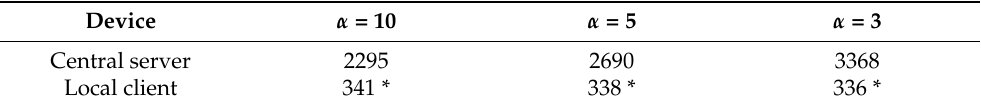
Table 3. Number of sent/received model parameters with different degrees of heterogeneity in FedTCM ( c t = 4), * denotes the result of averaging.